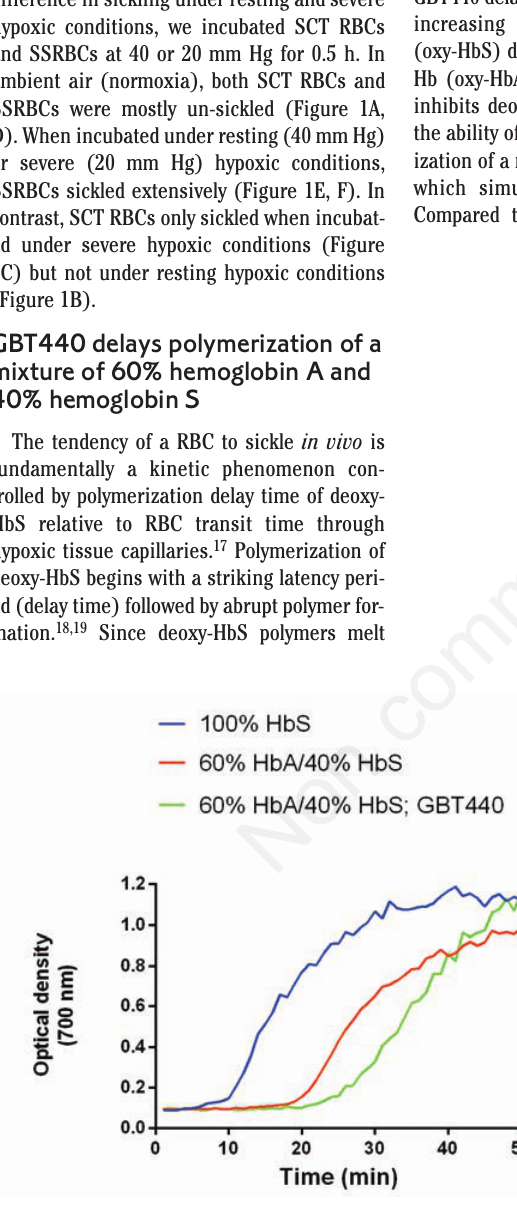
Figure 2. GBT44O delays polymerization of sickle cell trait hemoglobin (Hb) mixture (60% HbA/40% HbS). The optical density at 700 nm measures turbidity of the Hb solution which represents polymerization of HbS. The final concentration of GBT440 and total Hb were 100 µM and 50 µM, respectively. Representative curves of n=3 are shown.